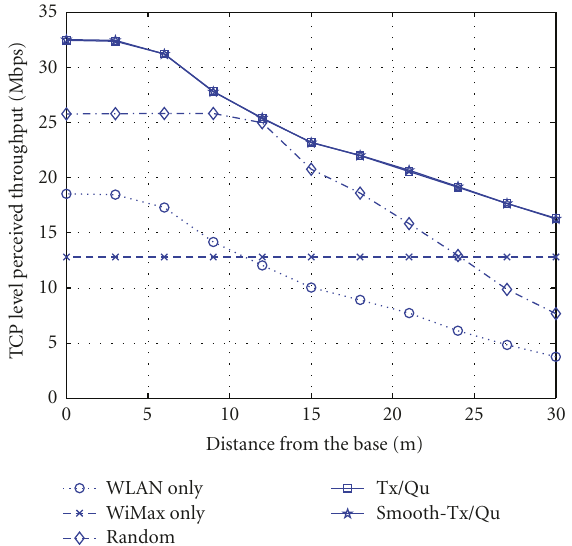
Figure 5: WLAN-WiMax heterogeneous networks. TCP level throughput varying the distance of the user from the AP/base station, for di ff erent MRRM schemes. No